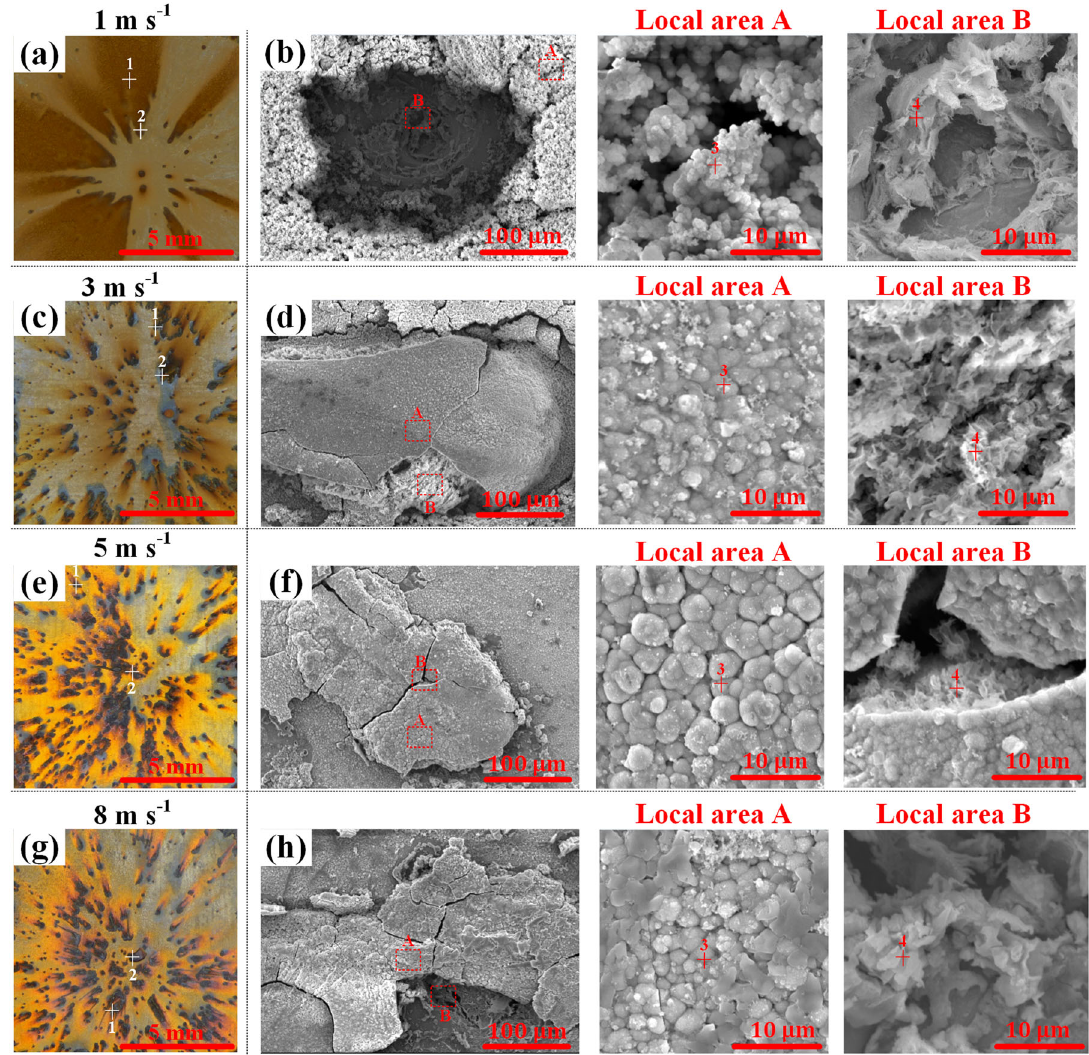
Fig. 2 Surface morphologies of the steel samples after tested in pure natural seawater. Photos ( a , c , e , g ) and SEM images ( b , d , f , h ) of the samples after FAC tests at different fl ow velocities. a , b 1 m s − 1 , c , d 3 m s − 1 , e , f 5 m s − 1 , g , h 8 m s − 1